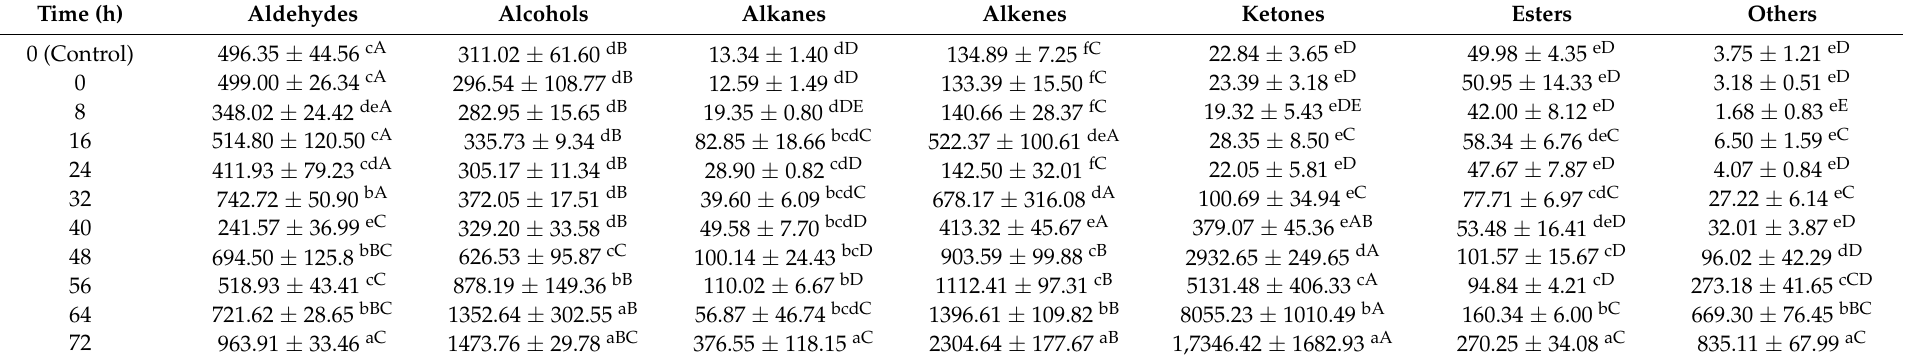
Data represent mean values ± standard deviations of three independent measurements. Values with different lowercase letters in the same column are significantly different ( p < 0.05); values with different capital letters in the same row are significantly different ( p <